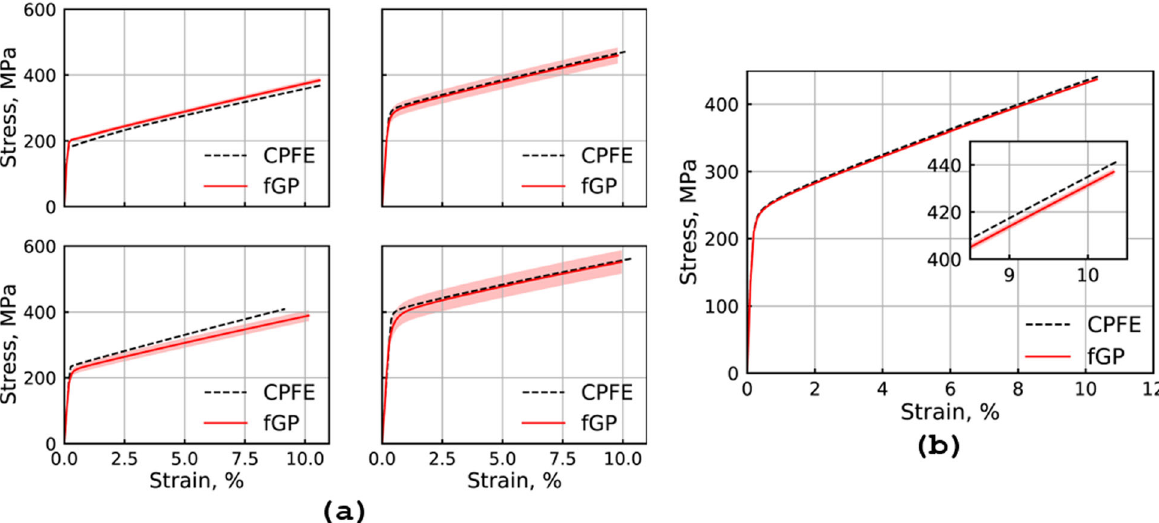
Fig. 4 fGP performance on withheld data. a fGP prediction with 95% prediction interval for four select grain data withheld from training. b fGP prediction with 95% prediction interval for the mean of all withheld data. Table 1. Withheld data error metrics.